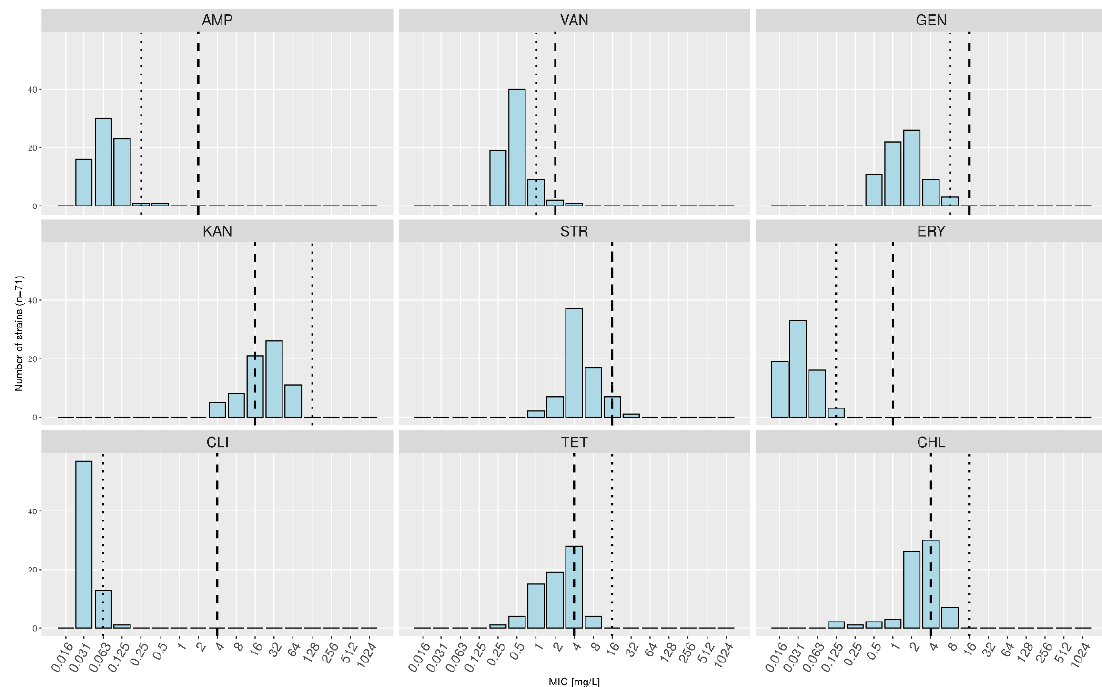
Figure 4. Minimal inhibitory concentration (MIC) distributions for Lactobacillus delbrueckii subsp. lactis only. The dashed lines indicate the current microbiological cutoffs (MCs) as defined by the European Food Safety Authority, and the dotted lines represent the calculated MCs based on the MICs measured in this study.